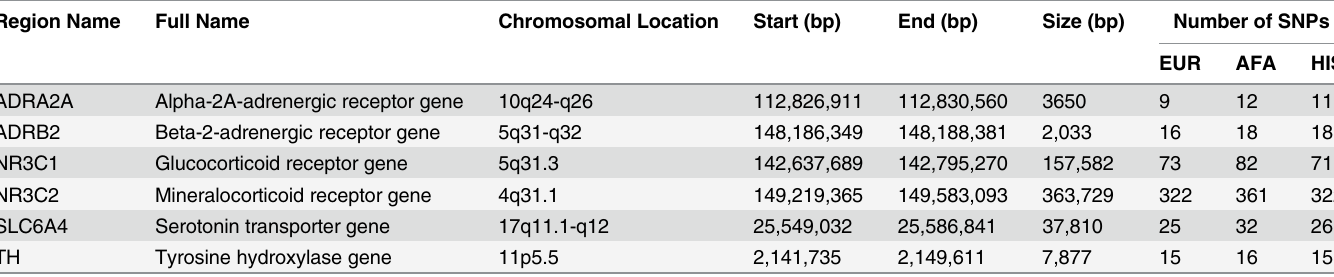
Table 2. Characteristics of the stress response